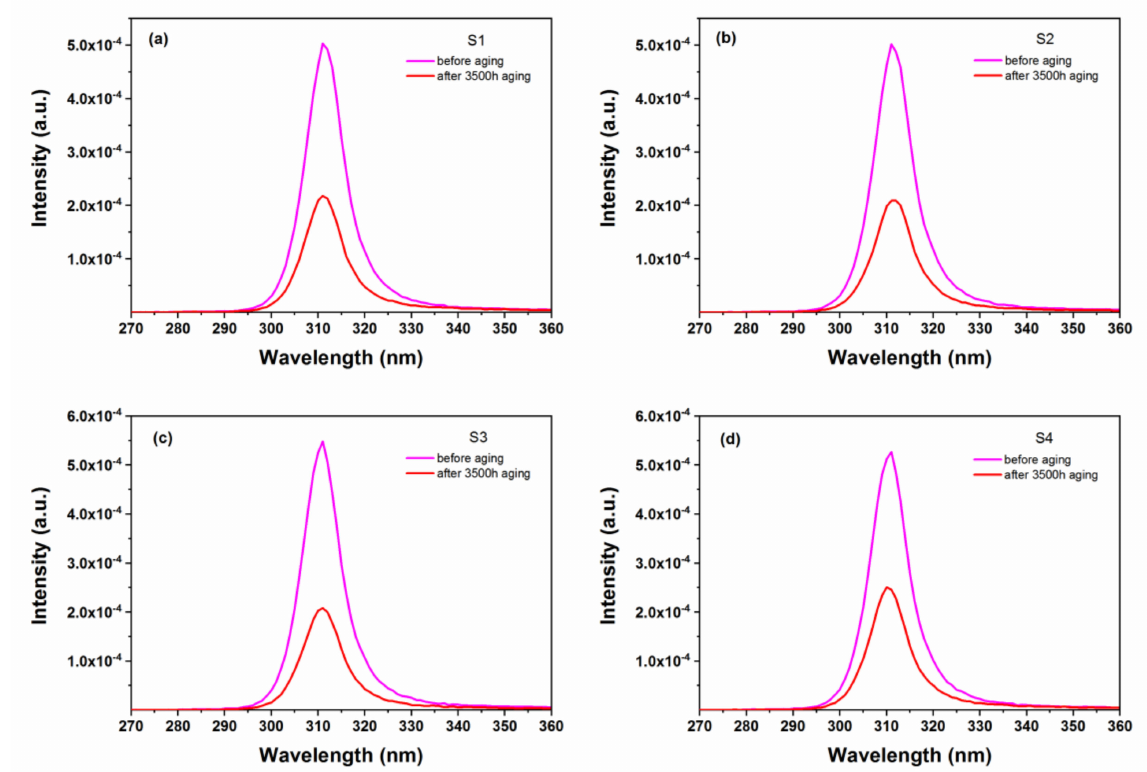
Figure 5. EL spectral characteristics of samples ( a ) S1, ( b ) S2, ( c ) S3, and ( d ) S4 measured at 100 mA before and after 3500 h of